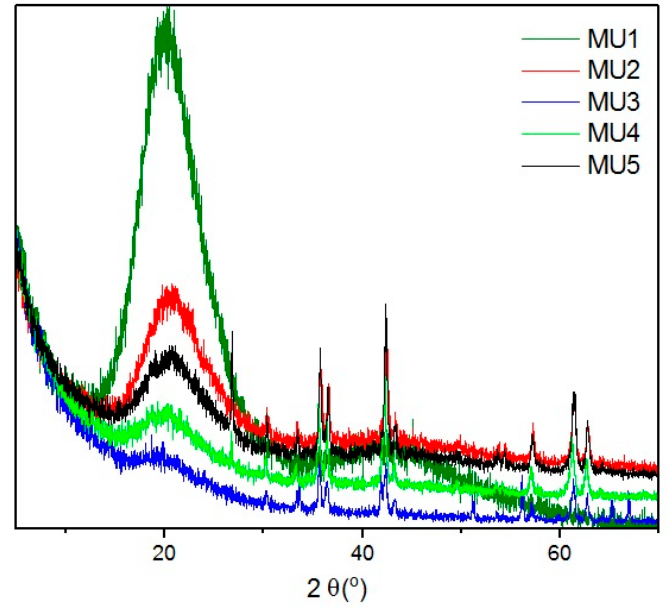
Figure 5. Diffractograms of different composites.